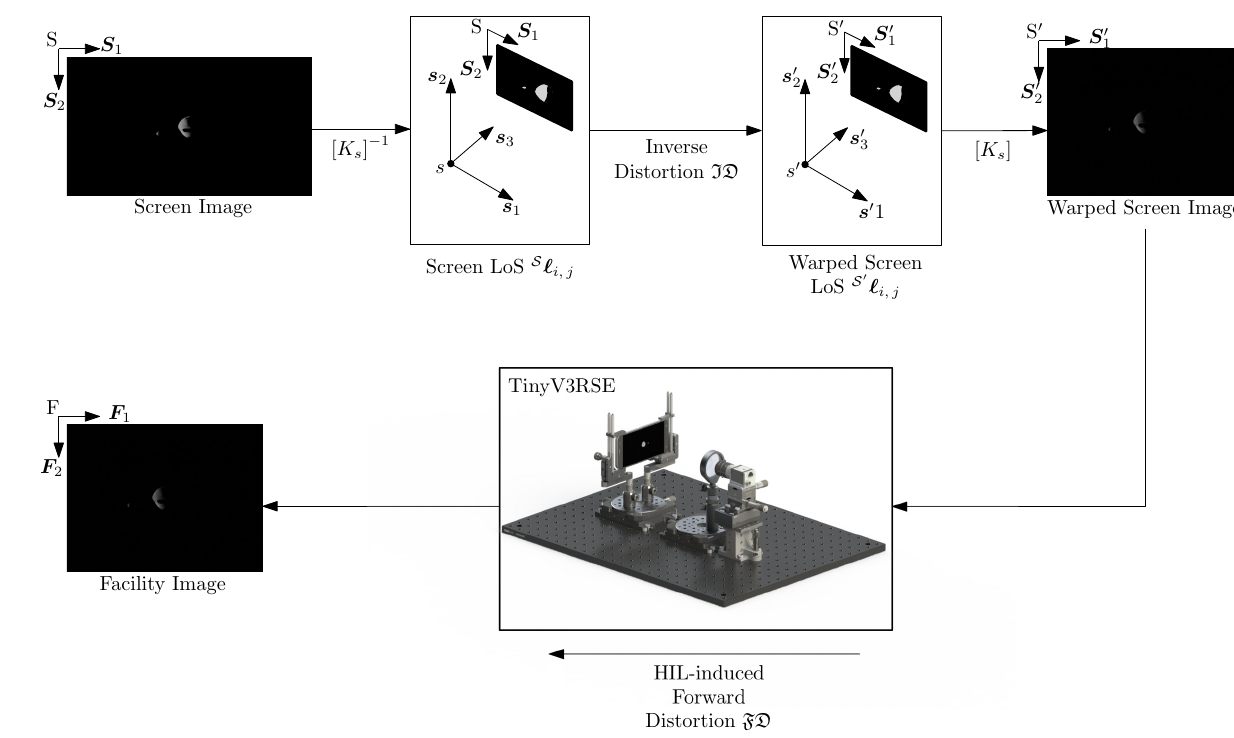
Figure 11. Upstream